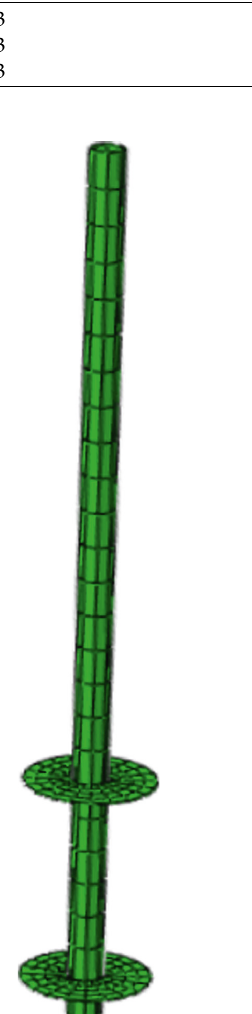
Figure 6: Screw anchor